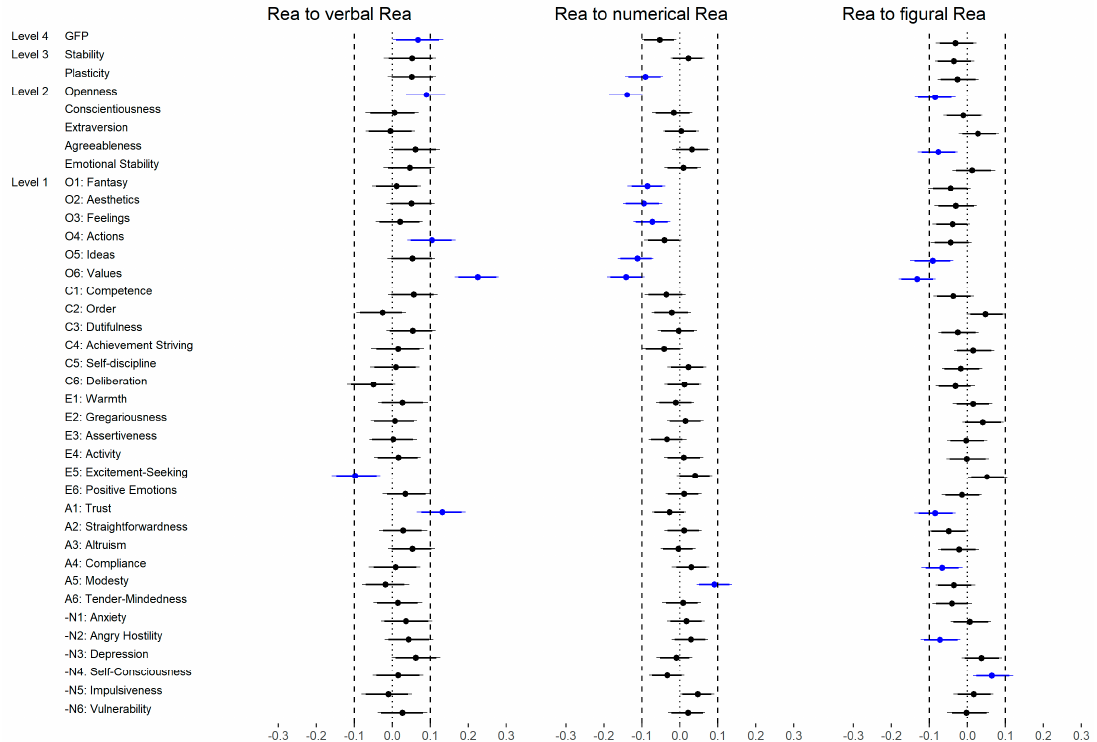
Figure 6. Study 1: Evaluation of the Brunswik Symmetry principle with regard to reasoning. Change of correlations when specific reasoning abilities (low level) were considered instead of general reasoning (medium level). Rea = Reasoning. Blue lines indicate substantially different correlations based on an equivalence testing approach. The facets of Neuroticism (-N) were reversed to be in line with the dimension of Emotional Stability.